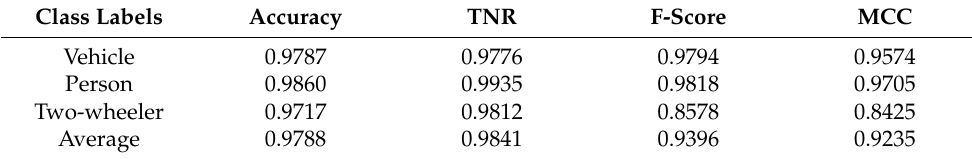
Table 2. Classification results of CIWHO-ORC technique on Bdd100k Dataset.